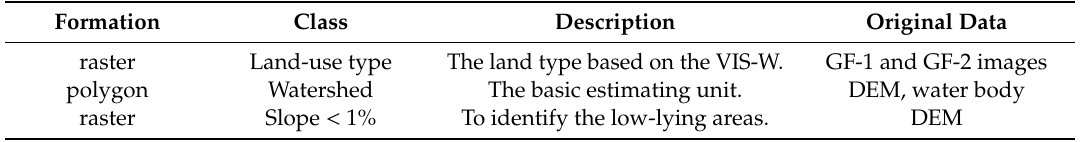
Table 1. The three basic maps need to be constructed. The land-use type is composed of the vegetation-impervious surface-soil and water (VIS-W) model which was extracted from GF-1 and GF-2. The watershed and the slope < 1% are derived by a digital elevation model